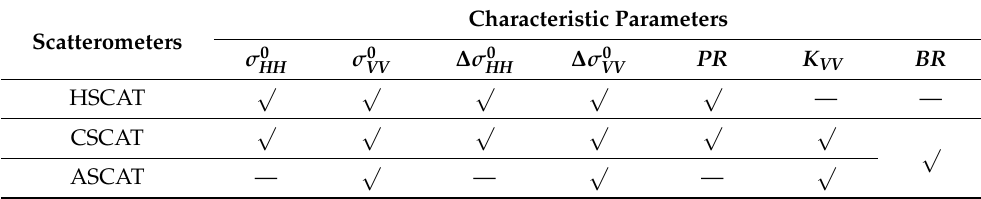
Table 2. Information on the characteristic parameters of multisource